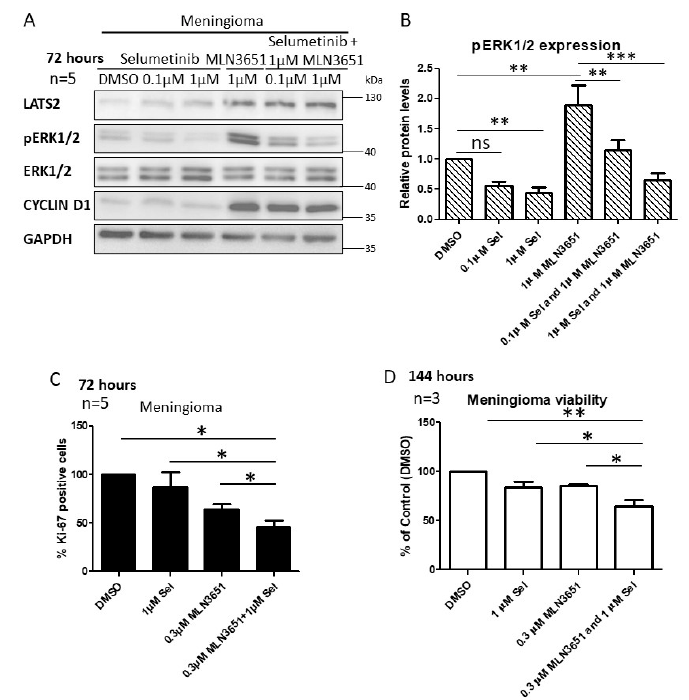
Figure 5. Simultaneous inhibition of CRL4-DCAF1 and MEK1 / 2 has an enhanced e ff ect on proliferation and cell viability of meningioma. ( A ) Western blot of primary meningioma cells treated with MLN3651 and / or selumetinib (Sel) for 72 hours, and probed for LATS2, pERK1 / 2, ERK1 / 2, CYCLIN D1 and GAPDH, representative of five replicates; ( B ) The graph shows the mean pERK1 / 2 expression with standard error of the mean (SEM), in combination with treated meningioma cells from (A) normalised to both total ERK1 / 2 and the loading control, Glyceraldehyde 3-phosphate dehydrogenase(GAPDH), and relative to DMSO, ns: not significant, ** p < 0.01, *** p < 0.0001; ( C ) Meningioma cells were treated with DMSO, 1 µ M Sel, 0.3 µ M MLN3651 or 1 µ M Sel and 0.3 µ M MLN3651 for 72 h and stained with Ki-67 antibody and DAPI. At least three images each of five replicates were quantified to calculate the percentage of Ki-67 positive cells. Combination of Sel and MLN3651 significantly reduced proliferation compared with either treatment alone, * p < 0.05; ( D ) Meningioma cells were treated with DMSO, 1 µ M Sel, 0.3 µ M MLN3651 or 1 µ M Sel and 0.3 µ M MLN3651 for 144 h, with three technical replicates, and viability was calculated comparative to the DMSO control, * p < 0.05, ** p < 0.01. The whole western blot image please find in Figure